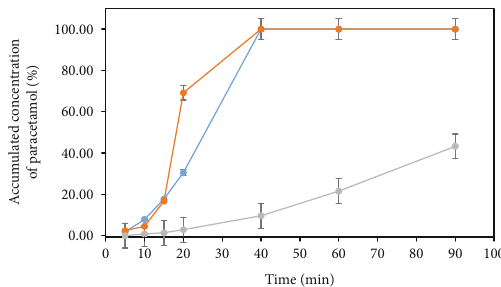
Figure 4: Dissolution pro fi le of paracetamol released from CRG- MD/SOR capsules at pH levels of 1.2 (blue), 4.5 (orange), and 6.8